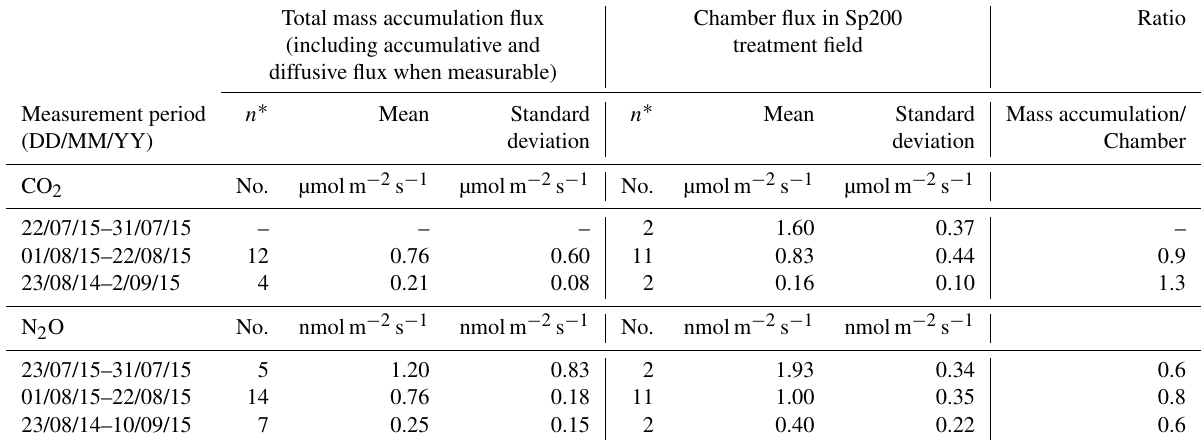
Table 5. Comparative mean daily fluxes of N 2 O and CO 2 across three similar flux periods. Total mass accumulation flux Chamber flux in Sp200 Ratio (including accumulative and treatment field diffusive flux when measurable) Measurement period n ∗ Mean Standard n ∗ Mean Standard Mass accumulation/ (DD/MM/YY) deviation deviation